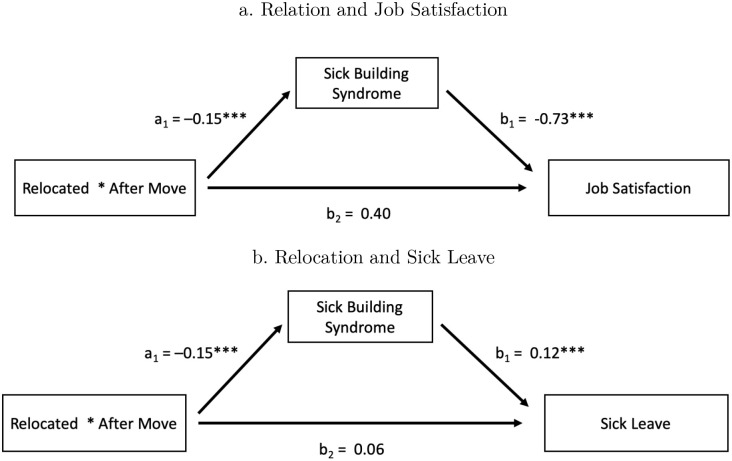
Impact of relocation on productivity.The figure shows sick building syndrome (SBS) as a mediator of the effect of the relocation to the new healthy building. The regressions include a dummy variable indicating whether the individual was in the relocated group, and survey-wave fixed effects. * p<0.1, ** p<0.05, *** p<0.01. The mediation equations are: Yit = τ1
After Movet + μ1
Relocatedi + b1
SBSit + b2
Relocated * After Moveit + ϵit1 (4) SBSit = τ2
After Movet + μ2
Relocatedi + a1
Relocated * After Moveit + ϵit2 (5) Where Yit denotes the sick building syndrome (SBS) or job satisfaction of individual i in survey wave t.